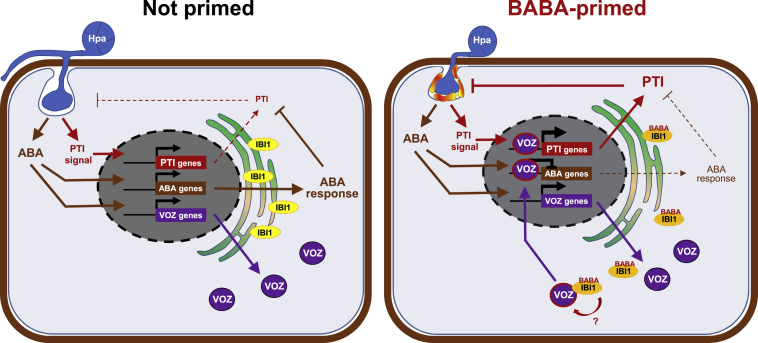
A Proposed Model Deciphering VOZ-Dependent Priming of Plant Immunity by BABA.Binding of BABA to its ER-localized receptor IBI1 primes this protein for pathogen-induced translocation to the cytoplasm (Luna et al., 2014). Hpa stimulates ABA signaling in the cell, which suppresses pattern-triggered immunity (PTI; Asai et al., 2014), but also increases VOZ gene expression. The combined induction of early-acting PTI genes and ABA-responsive abiotic tolerance genes (ABA genes) causes moderate levels of ER stress, which is sufficient to release IBI1 from the ER to the cytoplasm in BABA-primed cells. Cytosolic IBI1 subsequently interacts with the increased pool of VOZ transcription factors. Through yet unknown mechanisms, this interaction stimulates translocation of VOZ to the nucleus, where it represses expression of ABA genes while (directly or indirectly) increasing the expression of PTI genes (Nakai et al., 2013). The repressed ABA signaling in BABA-primed cells allows for augmented PTI signaling and resistance against Hpa, including callose-associated defense (Zimmerli et al., 2000; Ton et al., 2005; Schwarzenbacher et al., 2014). In unprimed cells, IBI1 is less responsive to Hpa-induced cytoplasmic translocation (Luna et al., 2014), which delays the IBI1/VOZ1/2-dependent signaling cascade. Consequently, there is no VOZ1/2-dependent repression of ABA signaling, resulting in basal resistance that is too weak to prevent infection. The model does not show the effects of the BABA-induced stress response, which may have a synergistic action on stress-related ABA signaling in the more sensitive ibi1-1 mutant during Hpa infection (Luna et al., 2014).